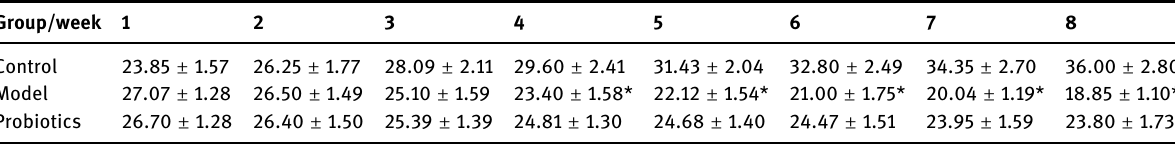
Table 1: E ff ects of Probio - M8 strains on weight ( g/day ) of T2D mice Group/week 1